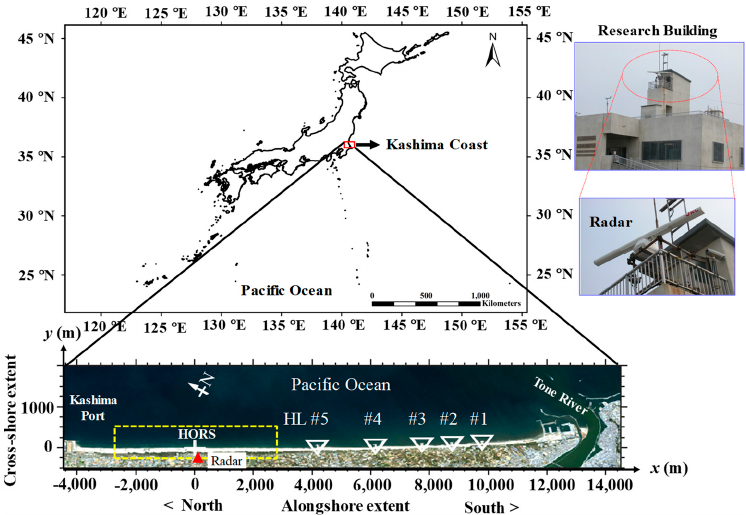
Figure 1. A location map of the study area: Kashima Coast, Japan. The red triangle indicates the radar location. The origin of the coordinate system is located at the base of HORS. The yellow rectangular box indicates the area covered by the radar observation, and the white triangles indicate the positions of the artificial headlands. Photos of the research building and radar are on the right.